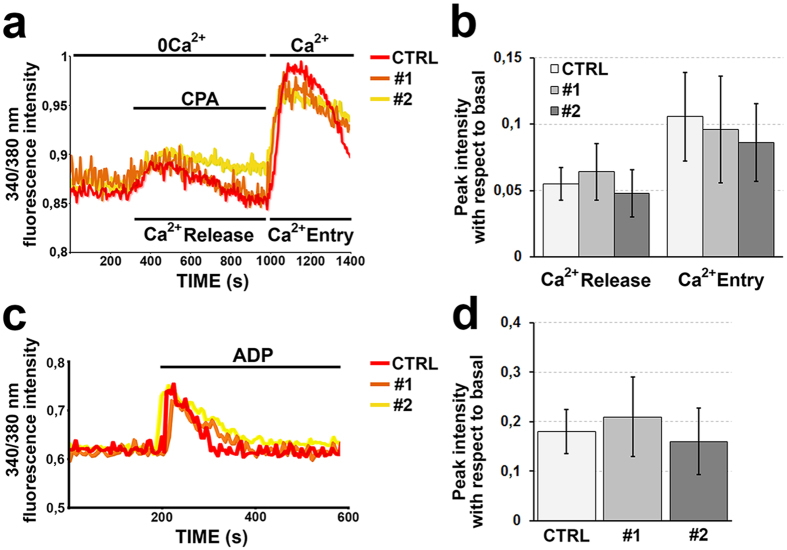
Calcium dynamics are maintained in gray platelet syndrome megakaryocytes.(a) Intracellular calcium (Ca2+) pools were depleted by exposing megakaryocytes to cycolpiazonic acid (CPA, 10 μM) in Ca2+-free (0Ca2+) solution. Re-addition of extracellular Ca2+ led to an increase in intracellular Ca2+ concentration which was indicative of activation of Store Operated Ca2+ Entry in both control (CTRL)- and #1 and #2 gray platelet syndrome (GPS)-derived megakaryocytes (red: CTRL; orange: #1 GPS; yellow: #2 GPS). (b) Statistical analysis of the peak amplitudes of both Ca2+ release and Ca2+ entry stimulated by CPA in CTRL- and #1and #2 GPS-derived megakaryocytes. Data are presented as means±SD (p = NS). (c) Adenosine diphosphate (ADP, 25 μM) evoked the activation of Ca2+ signaling in CTLR- and both #1 and #2 GPS-derived megakaryocytes (red: CTRL; orange: #1 GPS; yellow: #2 GPS). (d) Statistical evaluation of the effect of ADP treatment on the amplitudes of Ca2+ signaling in CTRL- and #1and #2 GPS-derived megakaryocytes. Data are presented as means±SD (p = NS).